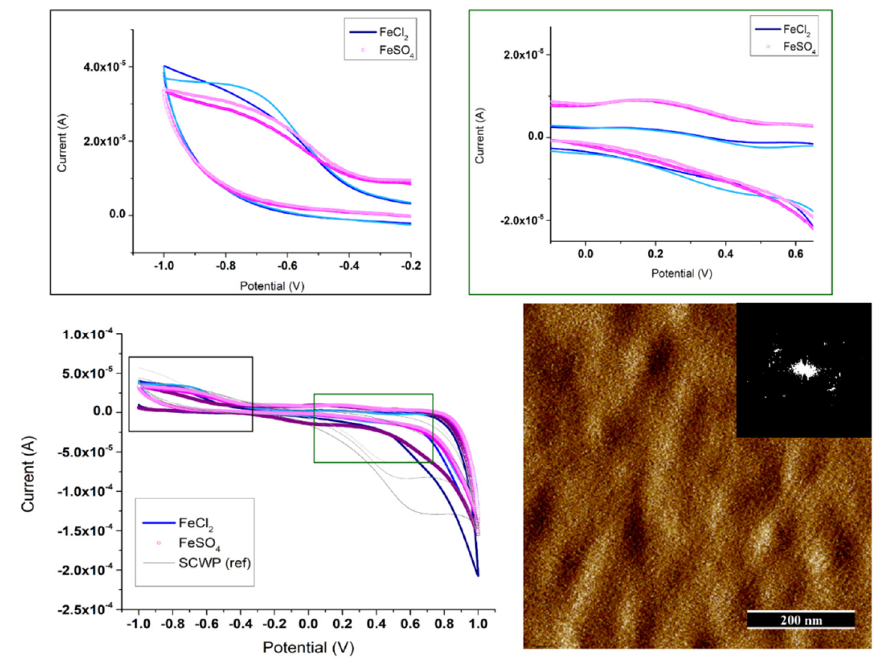
Figure 6. Influence of an underlying SCWP film on the SbpA film packing and ion permeability measured by Cyclic Voltammetry measurements ( − 1 to +1 V) on Fe 2+ –containing S-layers (FeCl 2 , dark to light blue solid lines versus FeSO 4 , purple to pink open circles). Experiments were performed in 0.1 M HEPES and the SCWP-coated gold system (grey) was employed as signal reference. Inset at the AFM topography micrograph shows the resulting Fourier spectra from the SbpA recrystallized film in the presence of FeSO 4 salt.